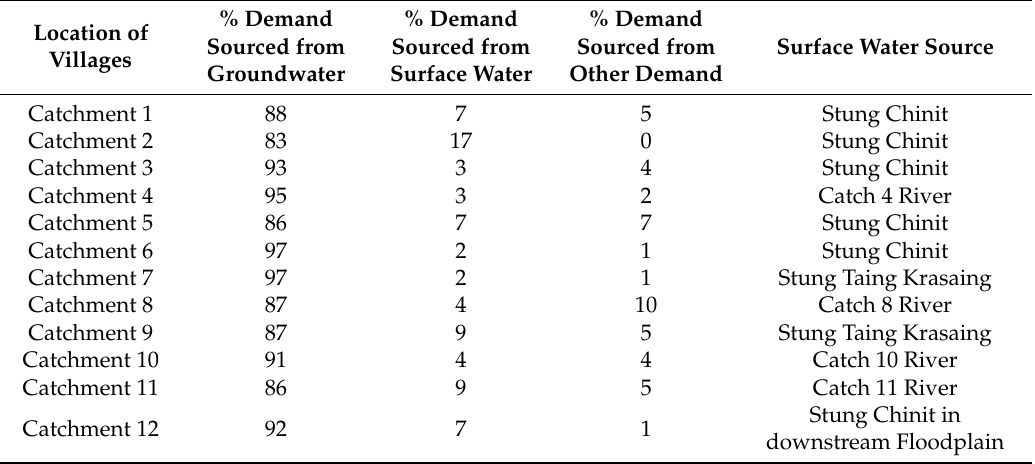
Table A4. Water source and use characteristics of village clusters.